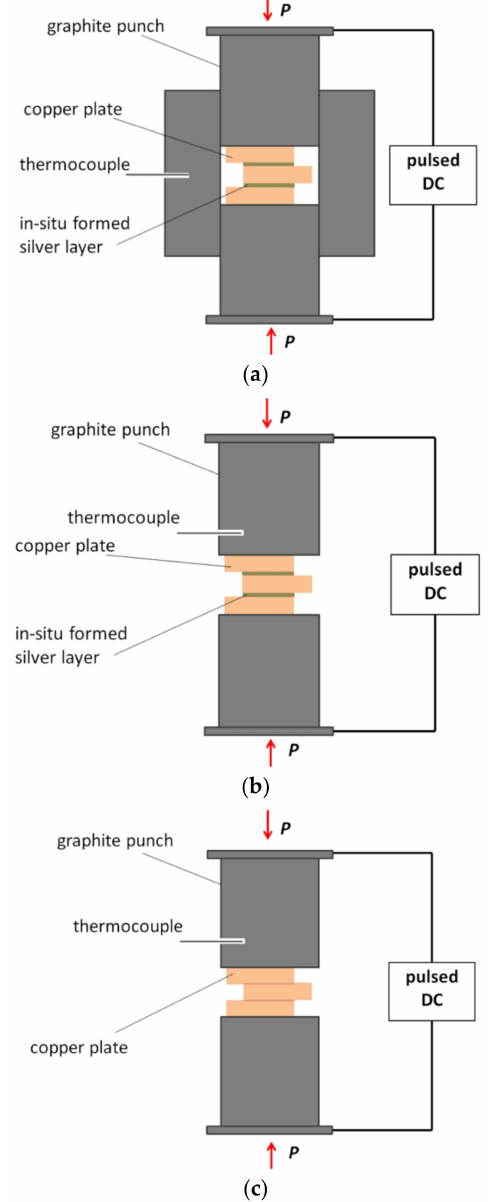
Figure 1. Schematics of the tooling configurations used for the Spark Plasma Sintering (SPS) joining experiments: ( a ) die-assisted configuration, with an in situ formed silver brazing layer; ( b ) configuration without a die, with an in situ formed silver brazing layer; ( c ) configuration without a die, joining without a brazing